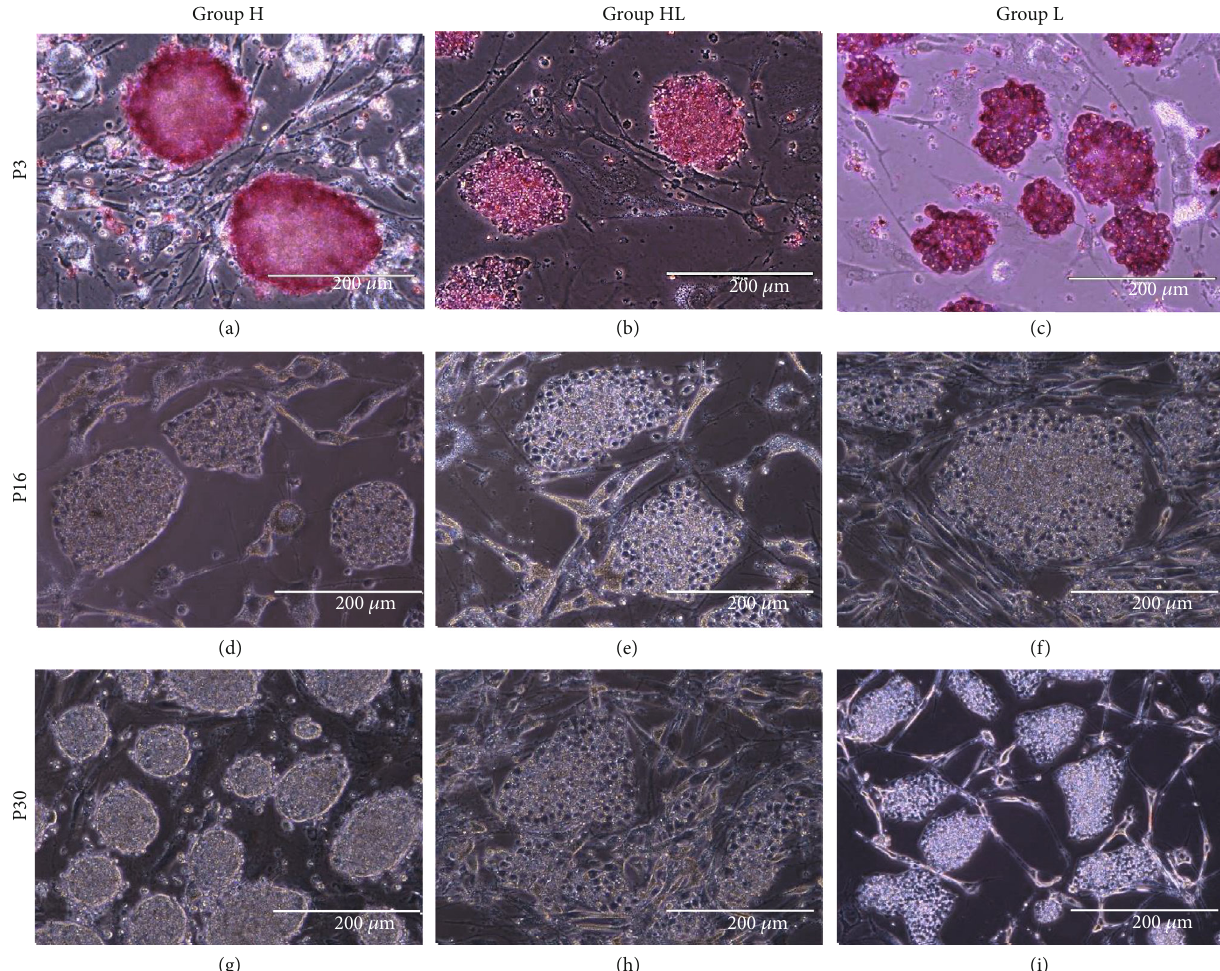
Figure 1: Alkaline phosphatase staining and di ff erent colony morphologies in passages 3, 16, and 30: (a, d, g) group H; (b, e, h) group HL; (c, f, i) group L. Scale bars: 200 μ